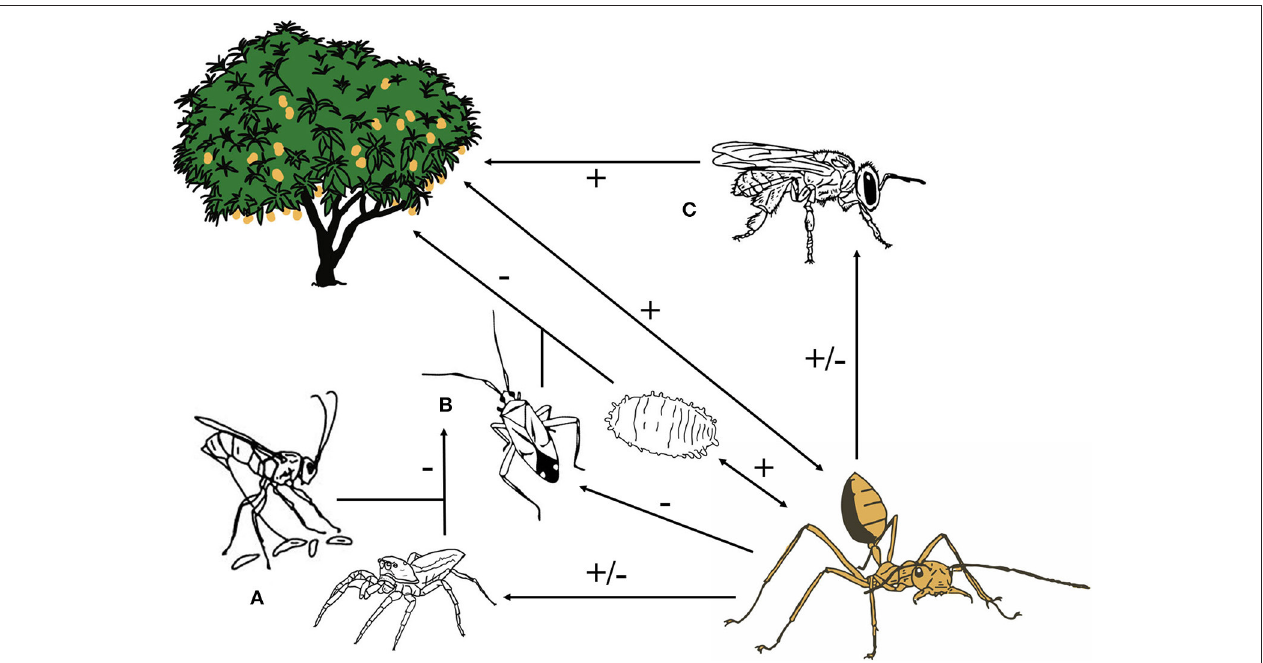
FIGURE 5 | Weaver ants ( Oecophylla spp.) interact with predators and parasitoids (A) , pests (B) , pollinators (C) , and a host tree. Overall impacts of Oecophylla spp. on these groups of arthropods and their host tree can be positive, negative, or both where certain groups of predators, parasitoids or pollinators benefit from ant presence, while others are deterred. Information on these interactions was gathered from a global meta-analysis on both O. smaragdina and O. longinoda as biological control agents in mango, cashew, and other tropical crops.